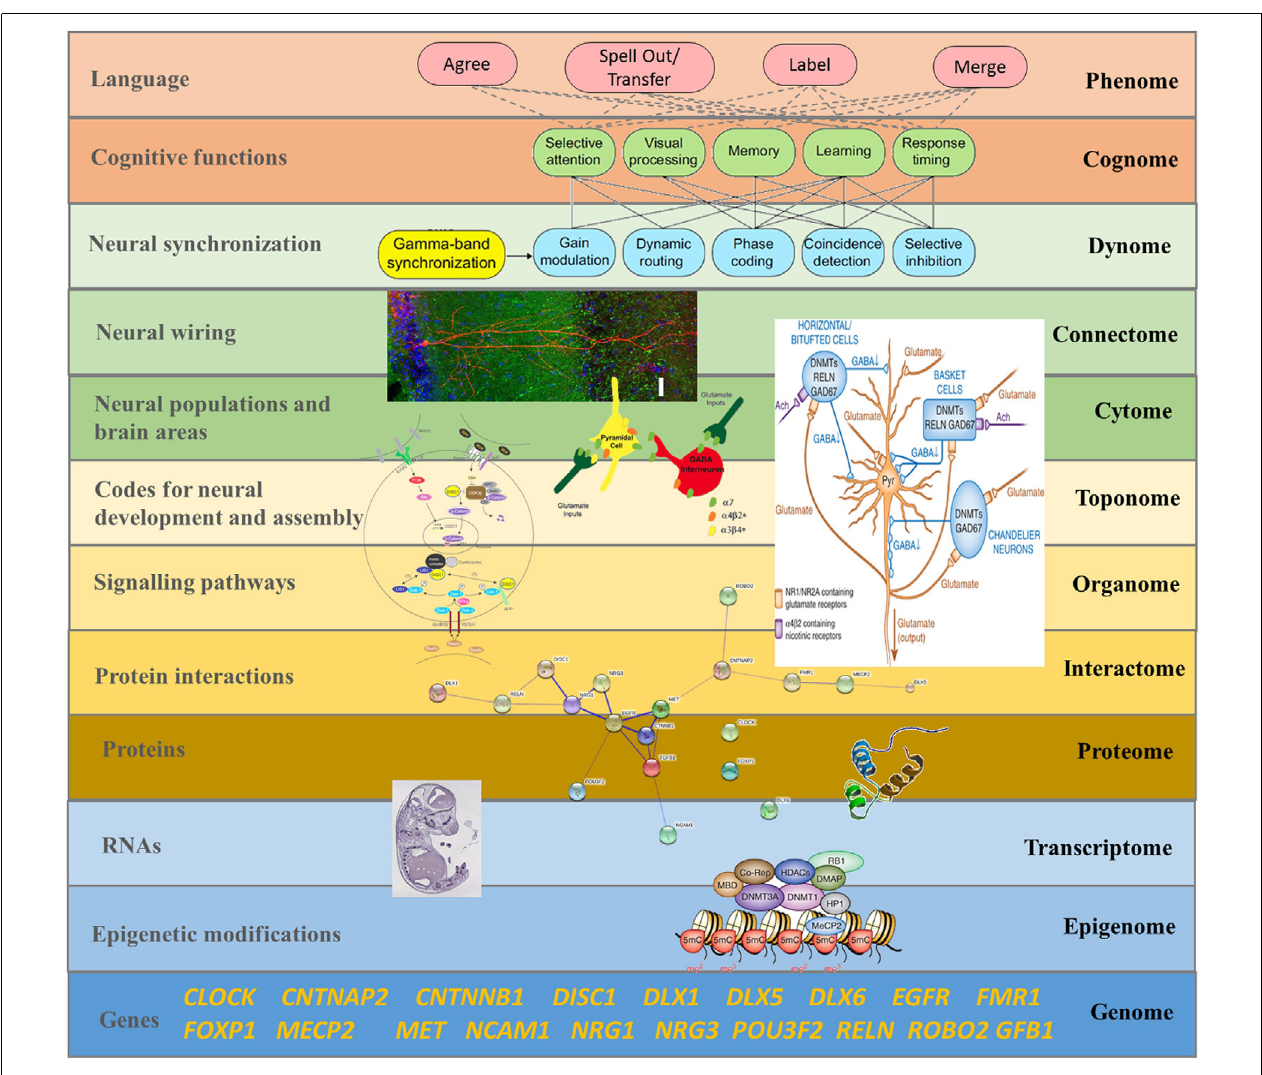
FIGURE 3 | The “Who” Question: a systems biology approach to language, focused on the dynamics of cellular and organismal function and on the (emergent) properties of the whole system, is suggested if one wants to understand how language emerges from these complex interactions (reproduced from Murphy and Benítez-Burraco, 2017; Figure